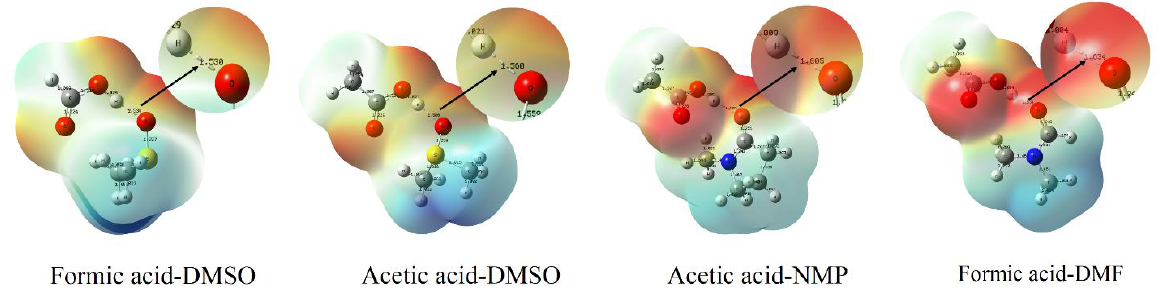
Table 3. NPA charges of hydrogen bond atoms, hydrogen bond length, and energy.